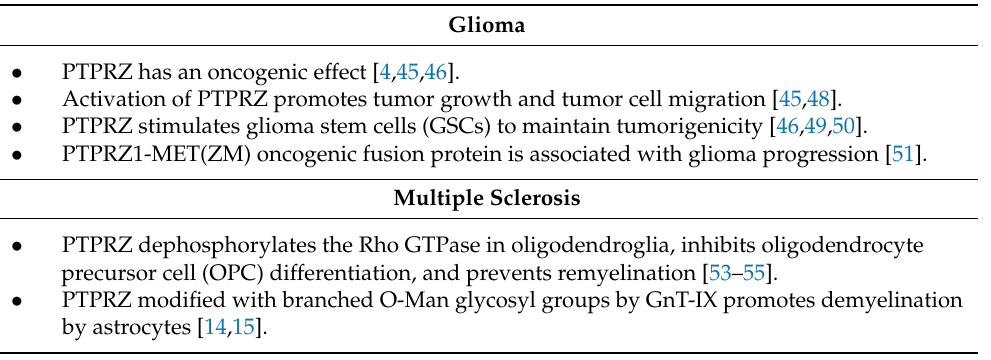
Table 1. Role of PTPRZ in glioma and multiple